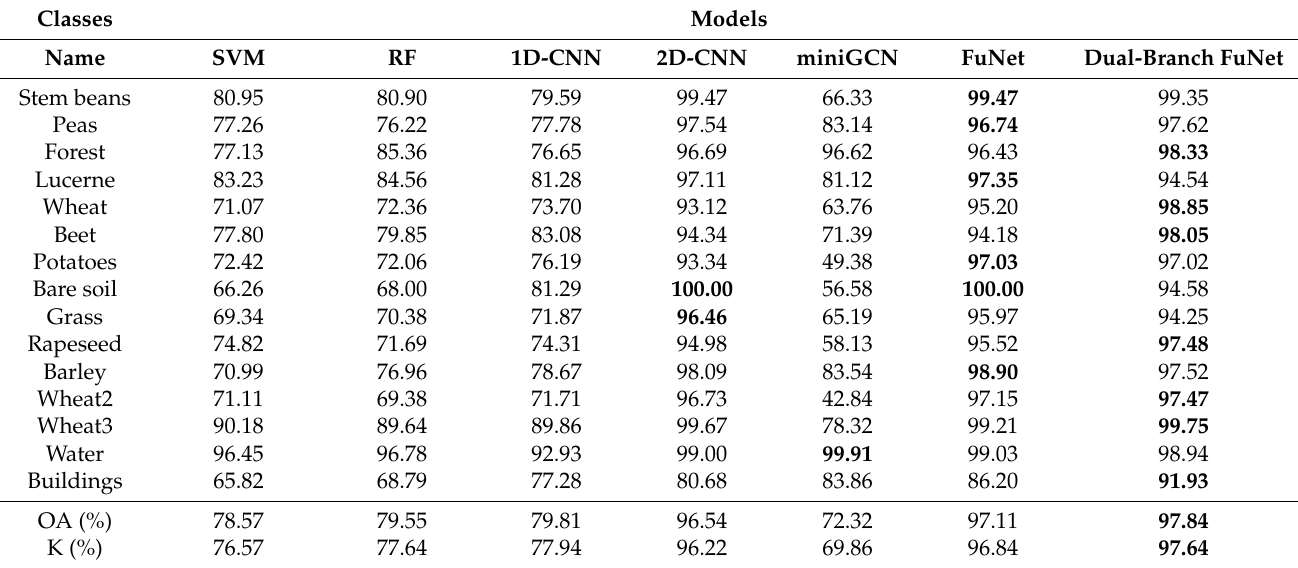
Table 4. Detailed classification OAs and K of different algorithms compared to the proposed method on AIRSAR Flevoland. Bold numbers indicate the highest accuracy in each row.